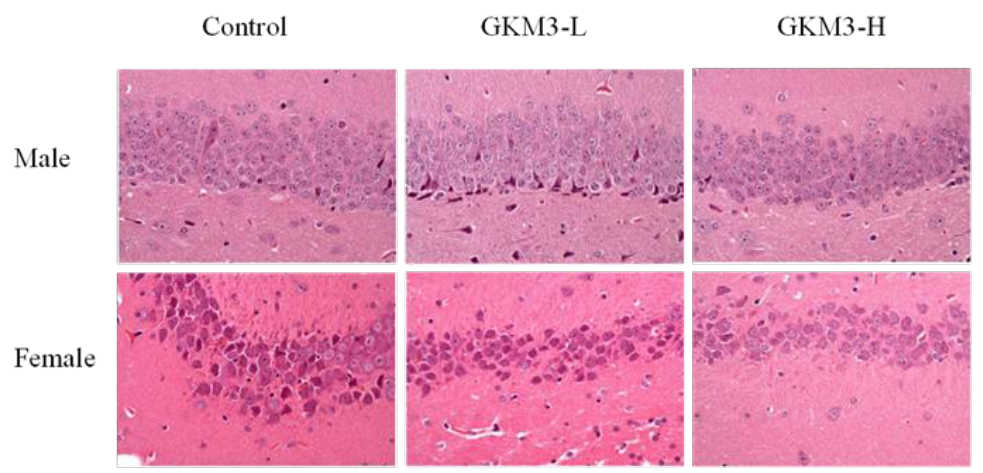
Figure 6. The hematoxylin and eosin staining of the hippocampus area in SAMP8 mice brains after 14 weeks of probiotic GKM3 consumption. GKM3-L: 1.0 × 10 9 CFU/kg BW/day (low dose); GKM3- H: 5.1 × 10 9 CFU/kg BW/day (high dose).